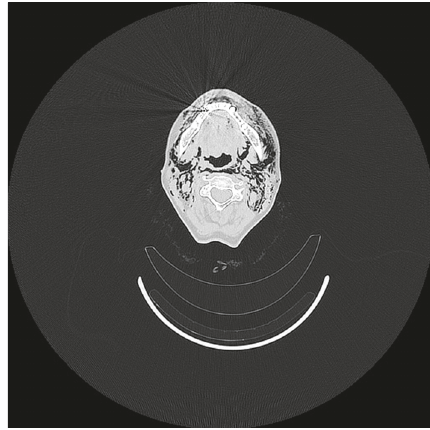
Figure 2: Computed tomographic axial view of the emphysema in the mandibular region.